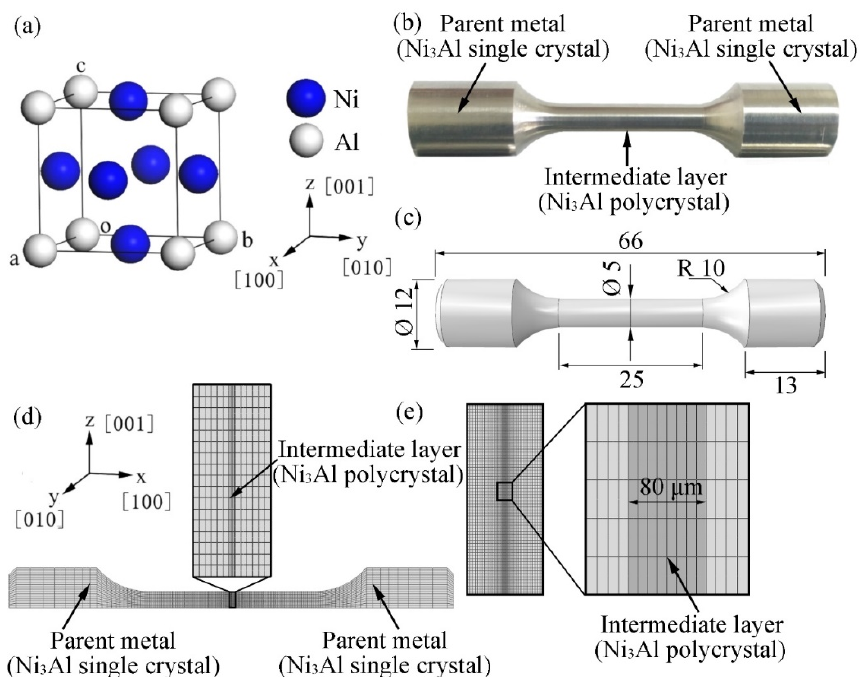
Figure 1. TLP bonded joint sample: ( a ) crystal structure of cubic Ni 3 Al, ( b ) a sample prepared in experiments, ( c ) the geometry of the sample for FE modeling (mm), and ( d ) the one-fourth 3D FE model and ( e ) submodel.